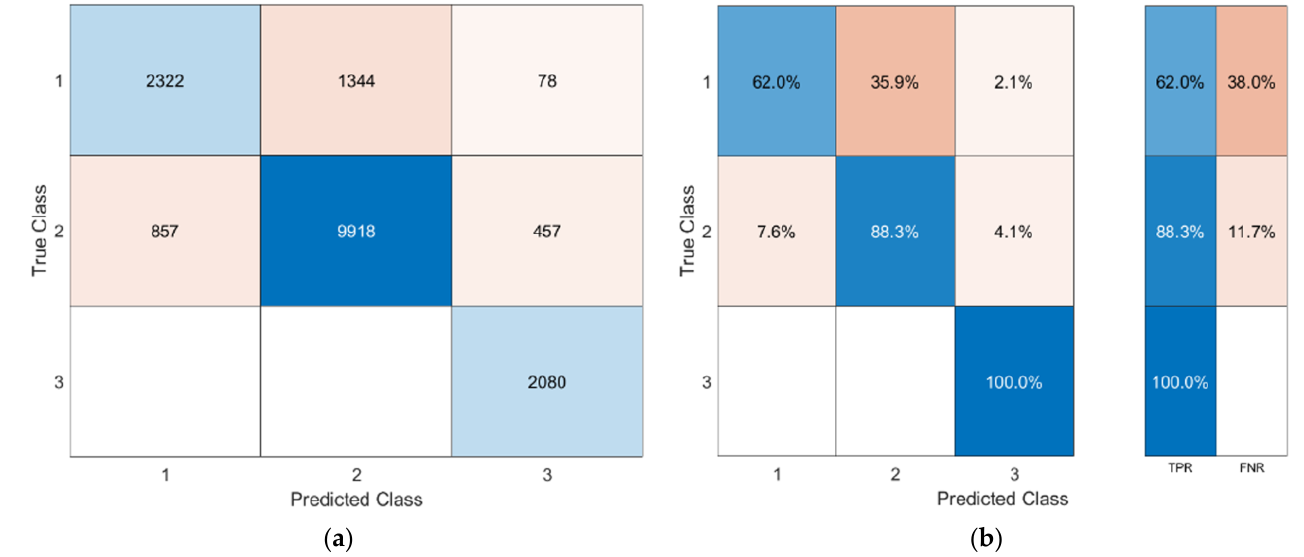
Figure 6. Confusion matrix corresponding to the highest accuracy shown in Table 6: ( a ) confusion matrix showing numerical values ( b ) TPR and FNR (in percentages).